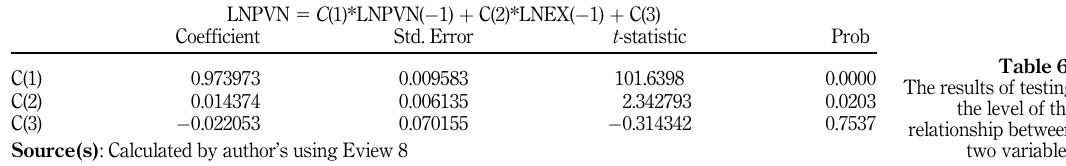
Table 6. The results of